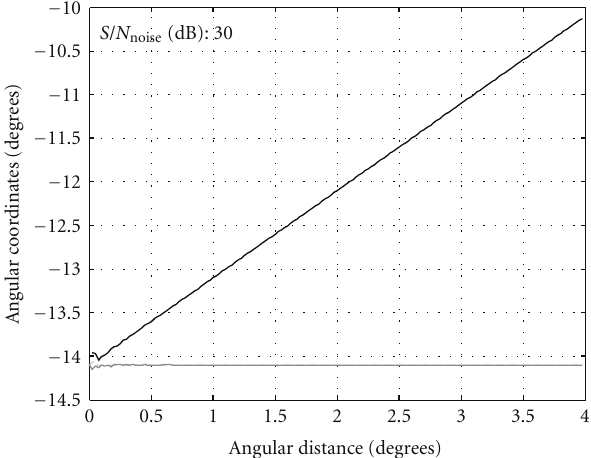
Figure 8: Histogram of polar coordinates evaluated by using the